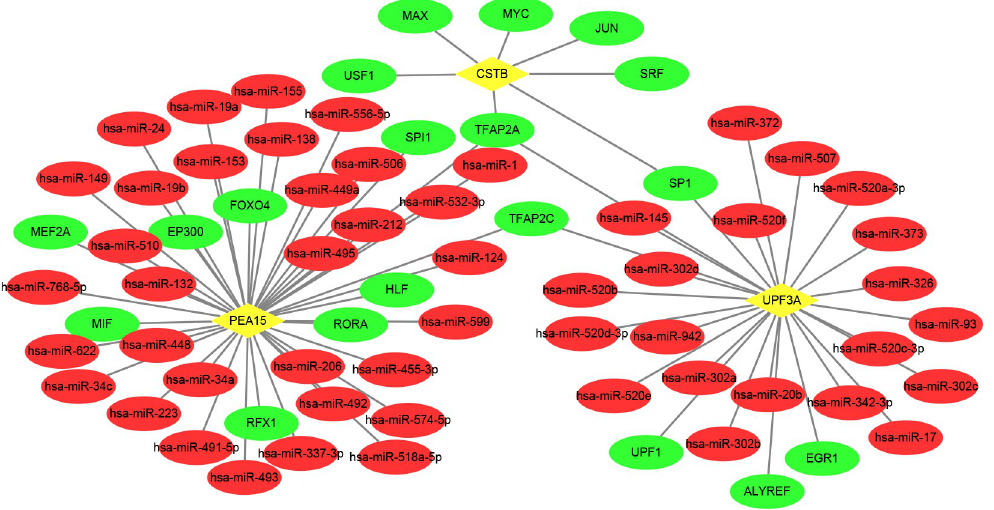
Fig 7. TF-miRNA coregulatory network including hub genes. The nodes with yellow diamonds are hub genes, red round nodes represent miRNA and green round nodes indicate TF.